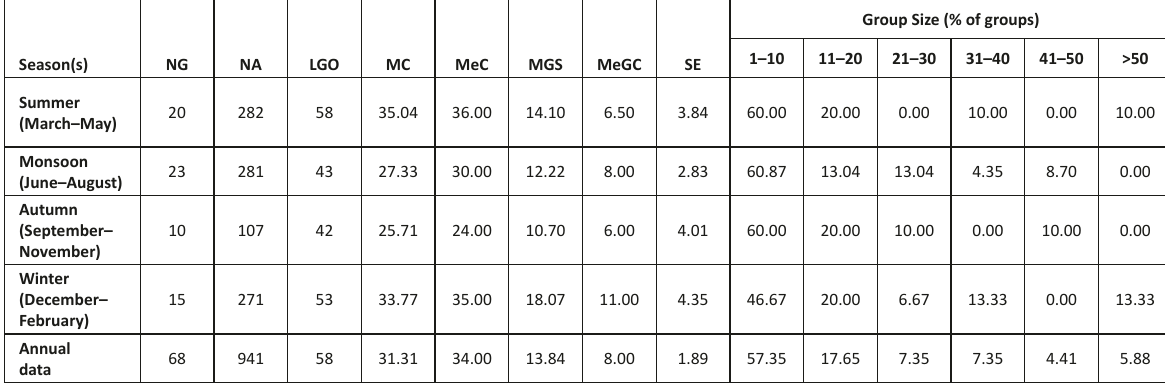
Table 1. Seasonal grouping patterns of Blackbuck in Lalpur Jheel, Dobhi Village of district Hisar, Haryana (India) from March 2017 to February 2018.